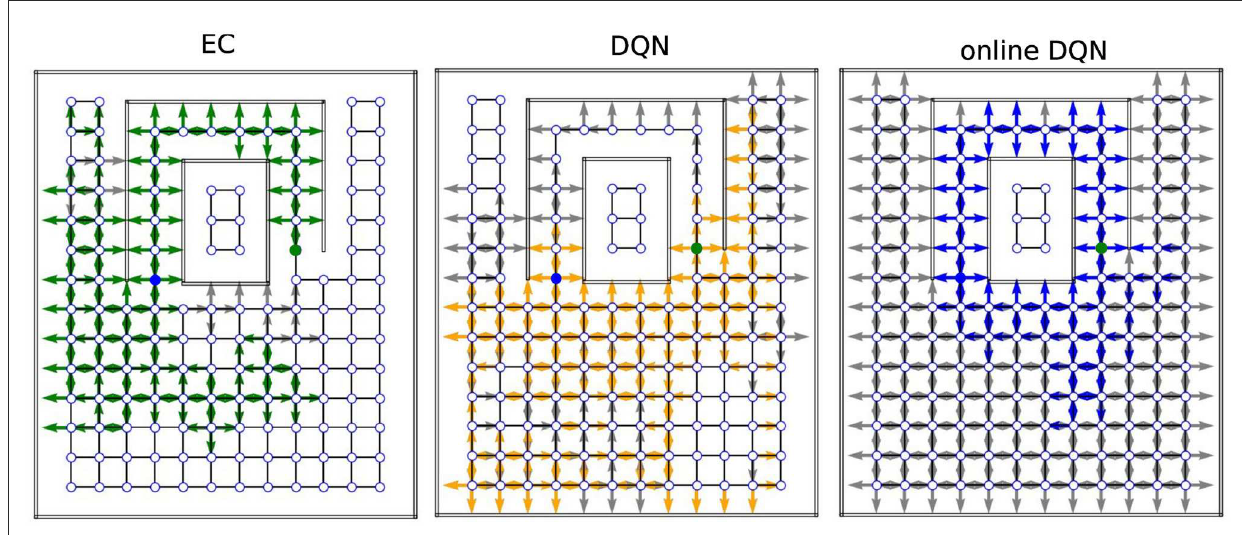
FIGURE8 Sample coverage and propagation of reward information in the tunnel maze. An arrow (gray/colored) indicates that the agent has visited the node. The direction of the arrow indicates the orientation of the agent, not the chosen action. A colored (green/orange/blue) arrow indicates that the agent can navigate to the goal, if placed on that node in that orientation. The starting and goal nodes are depicted in blue and green, respectively. EC, Model-free Episodic control; DQN, Deep Q network; online-DQN, online deep Q